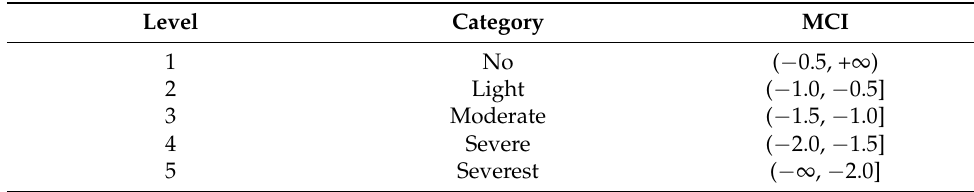
Table 1. Drought classification of MCI